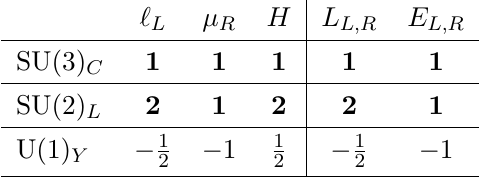
Table 1 . The quantum numbers of the SM and extra vector-like leptons in our